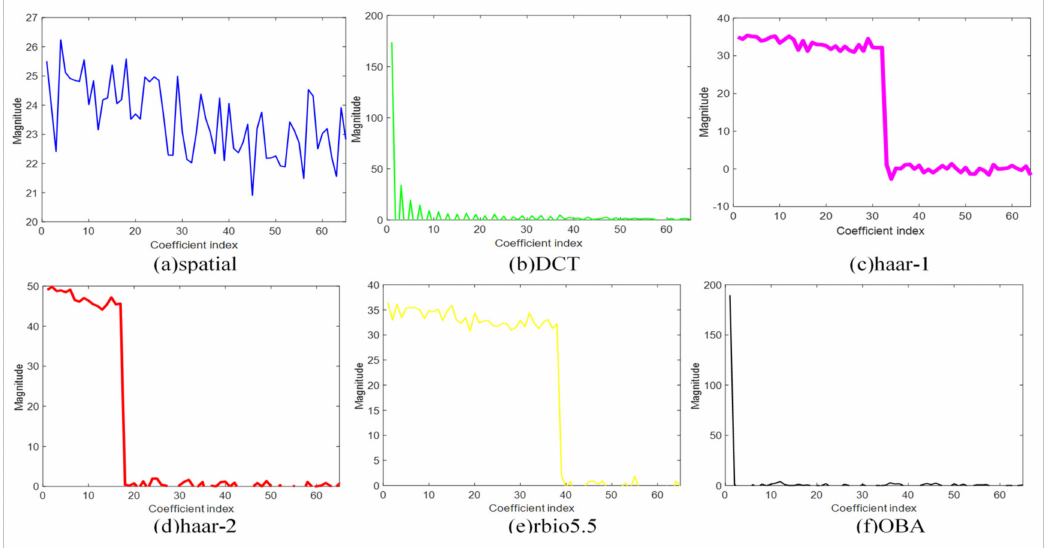
Figure 8. Sparsity performance of temperature of OrangeLab-Campaign A in six various sparse